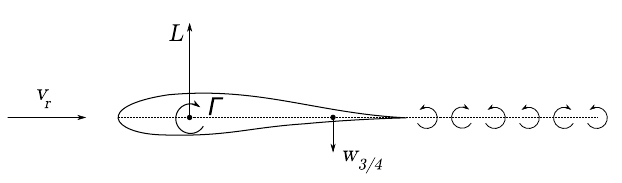
Figure 2. Cambered airfoil in parallel inflow to the chord line. The shed wake corresponds to the time history of the bound